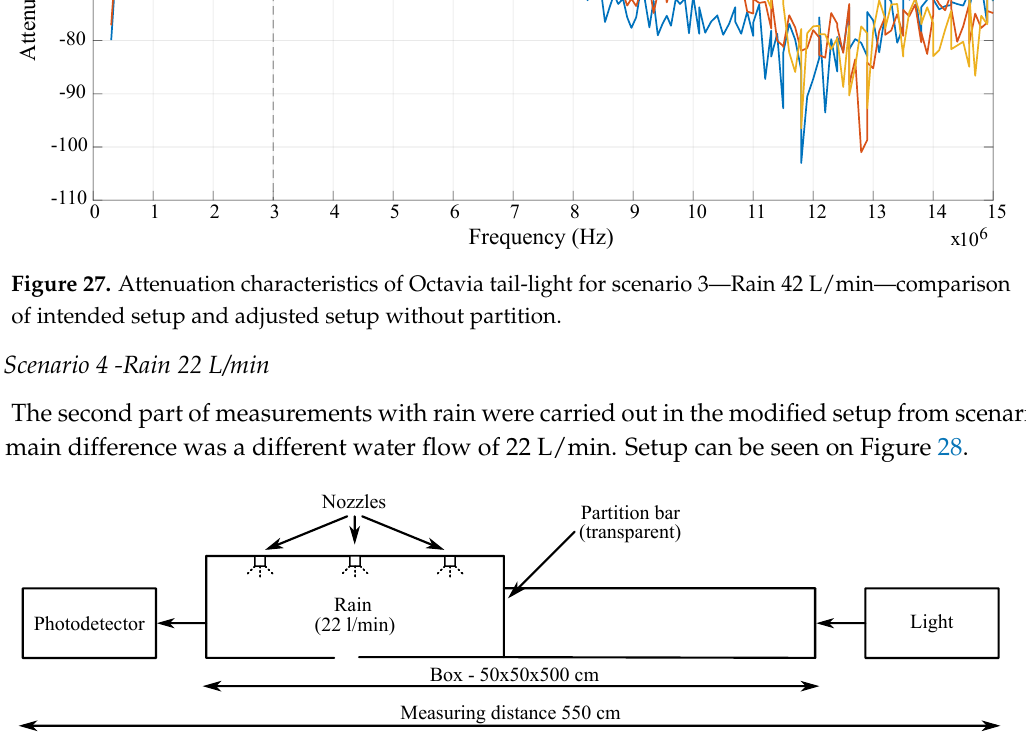
Figure 28. Octavia tail-light setup adjusted for scenario 4-Rain 22 L/min.